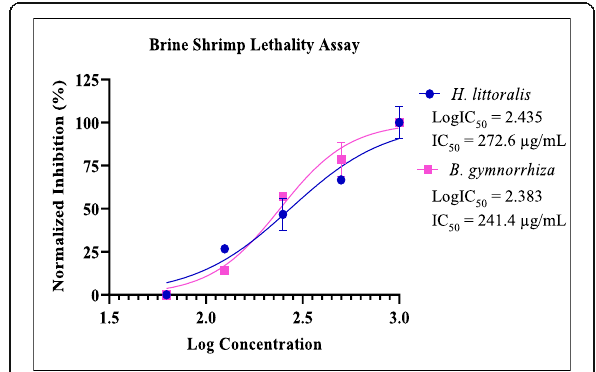
Fig. 4 Concentration-dependent brine shrimp lethality assay of methanol extracts of B. gymnorrhiza and H. littoralis . Values are expressed as Mean ± SEM ( n = 3). Graph represents the percentage of inhibition against log of concentration